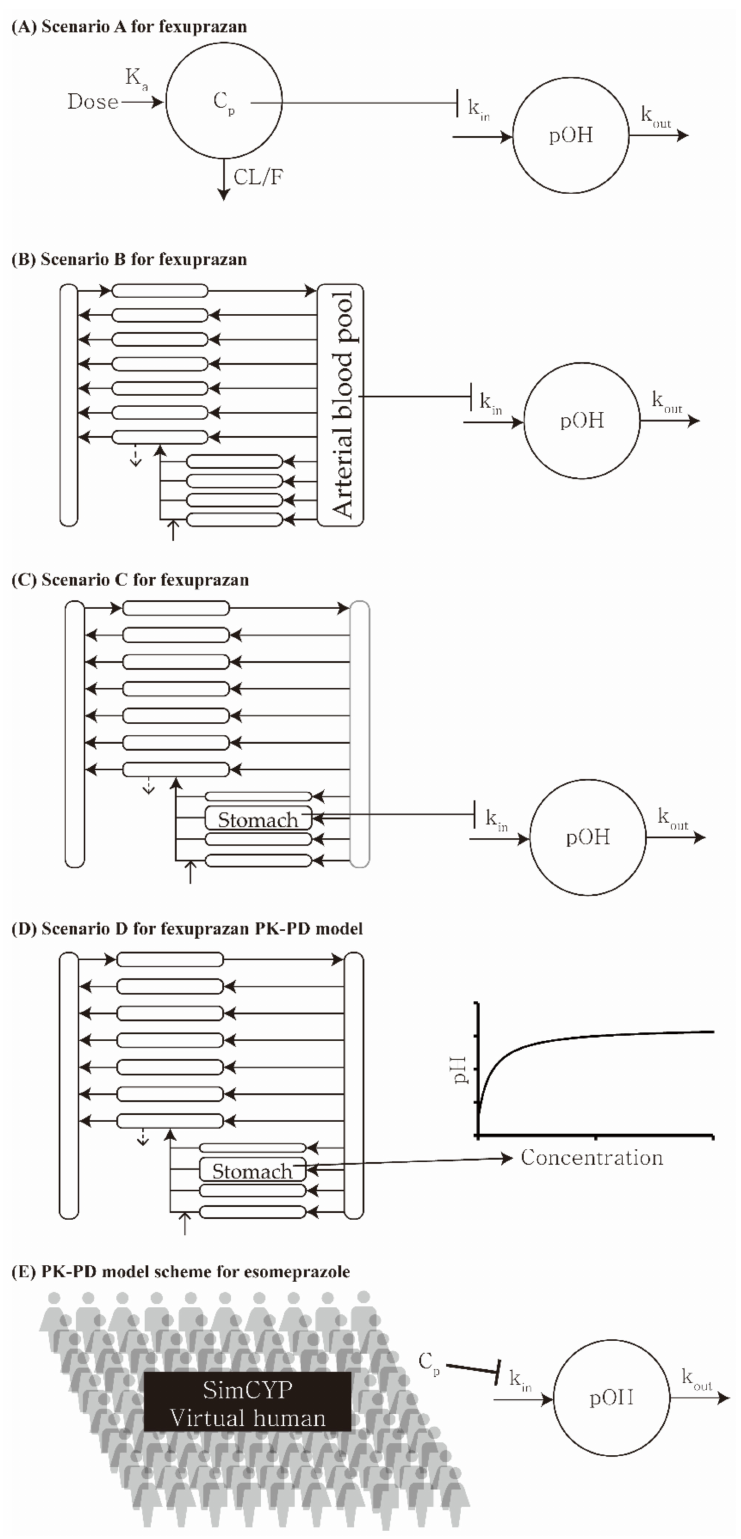
Figure 1. Model scheme for the PK–PD model of orally administered fexuprazan and esomeprazole in humans. Four PK–PD models were used for fexuprazan, and one PK–PD model was used for esomeprazole. The PD models for fexuprazan incorporated plasma or stomach concentration, and the one for esomeprazole used plasma concentration. Indirect models were used for the three PK–PD models for fexuprazan (Scenario A, B, and C) and the one for esomeprazole. The direct model was used for the PK–PD model scenario